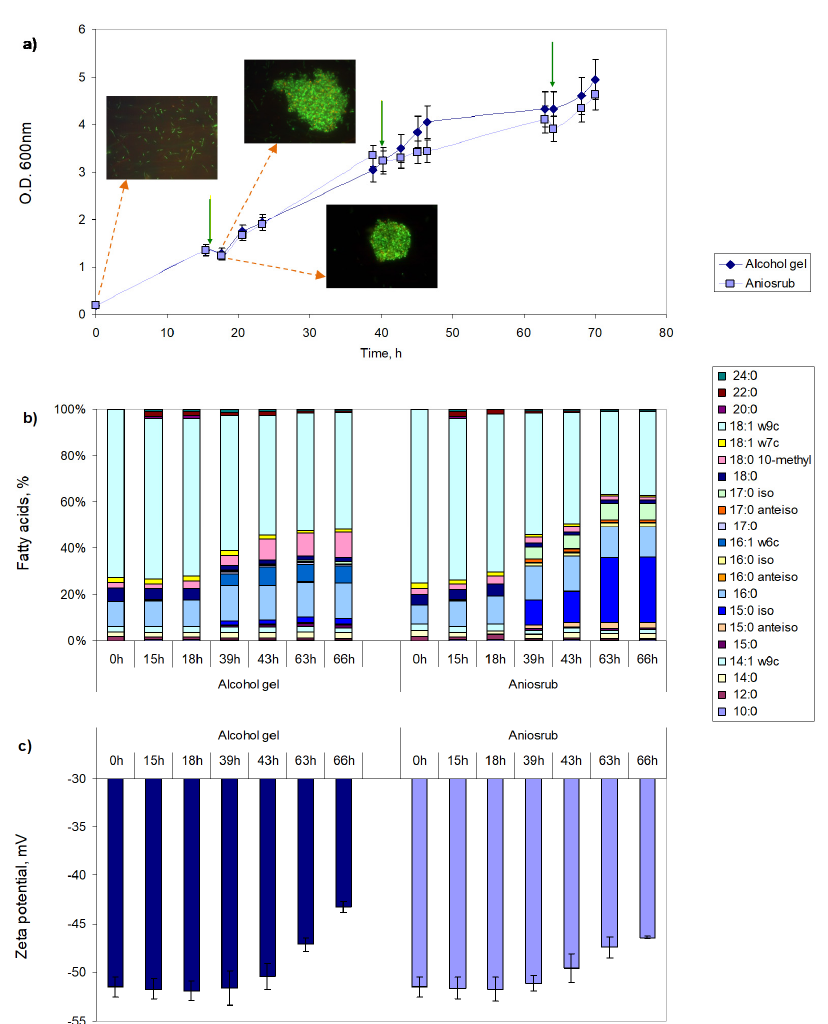
Figure 3. Adaptation of M. vaccae cells to alcohol gel and Aniosrub. ( a ) The disinfectants were added at 16, 40, and 64 h of growth (green arrows), causing cell aggregation in the following hour (fluorescence microscopy images indicated by orange arrows), which decreased the optical density (O.D. 600 nm) before growth was resumed. ( b ) Fatty acid composition of the cells at time zero, one hour prior disinfectant addition and at least two hours following addition. ( c ) Zeta potential of the cells measured at the same time as in ( b ). Only FA accounting for at least 1% of total lipids are represented. The content of each fatty acid presented in ( b ) may be found in Table